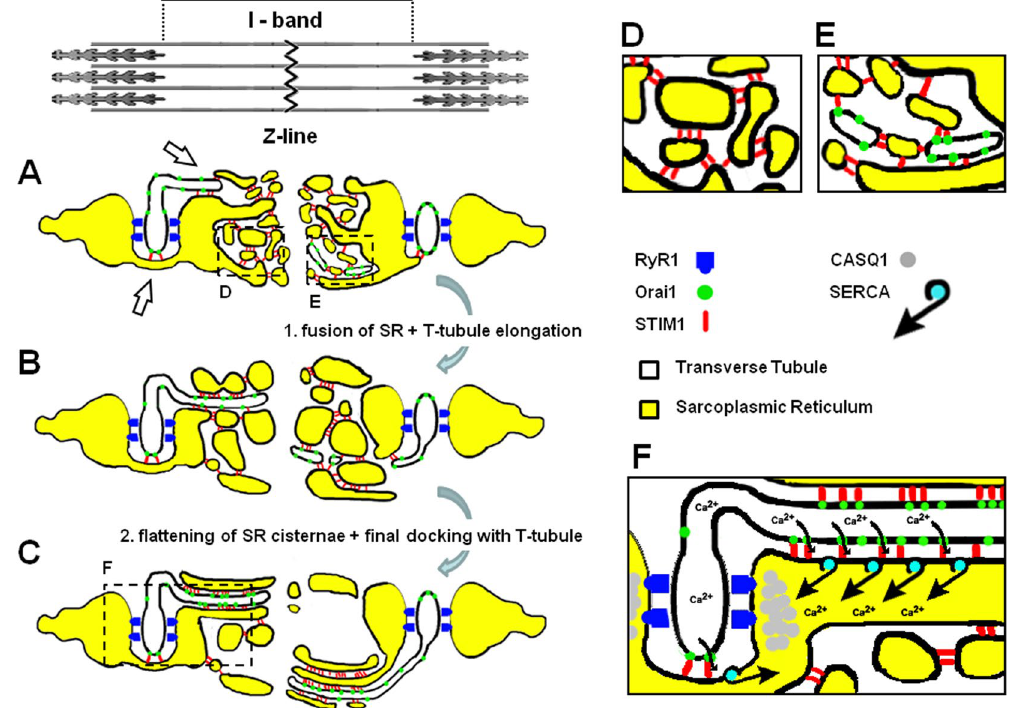
Figure 6. Model for exercise-dependent formation of Calcium Entry Units (CEUs). Main events leading to CEU formation: ( A -to- B ) fusion of free-SR into larger vesicles and elongation of TTs toward the I band; ( B -to- C ) flattening of SR membranes into parallel cisternae and final docking to elongated TTs. ( D and E ) Enlargements of dashed boxes in A: under control conditions, some membranes within the I band may ( E ) or may not ( D ) be of TT origin (and contain Orai1). ( F ) Enlargement of dashed box in C with modeling of the Ca 2 + entry pathway that would allow flow-back of ions to triads during exercise/fatigue. Empty arrows in A point to SR-TT contacts in proximity of triads, as imaged by EM in Fig.